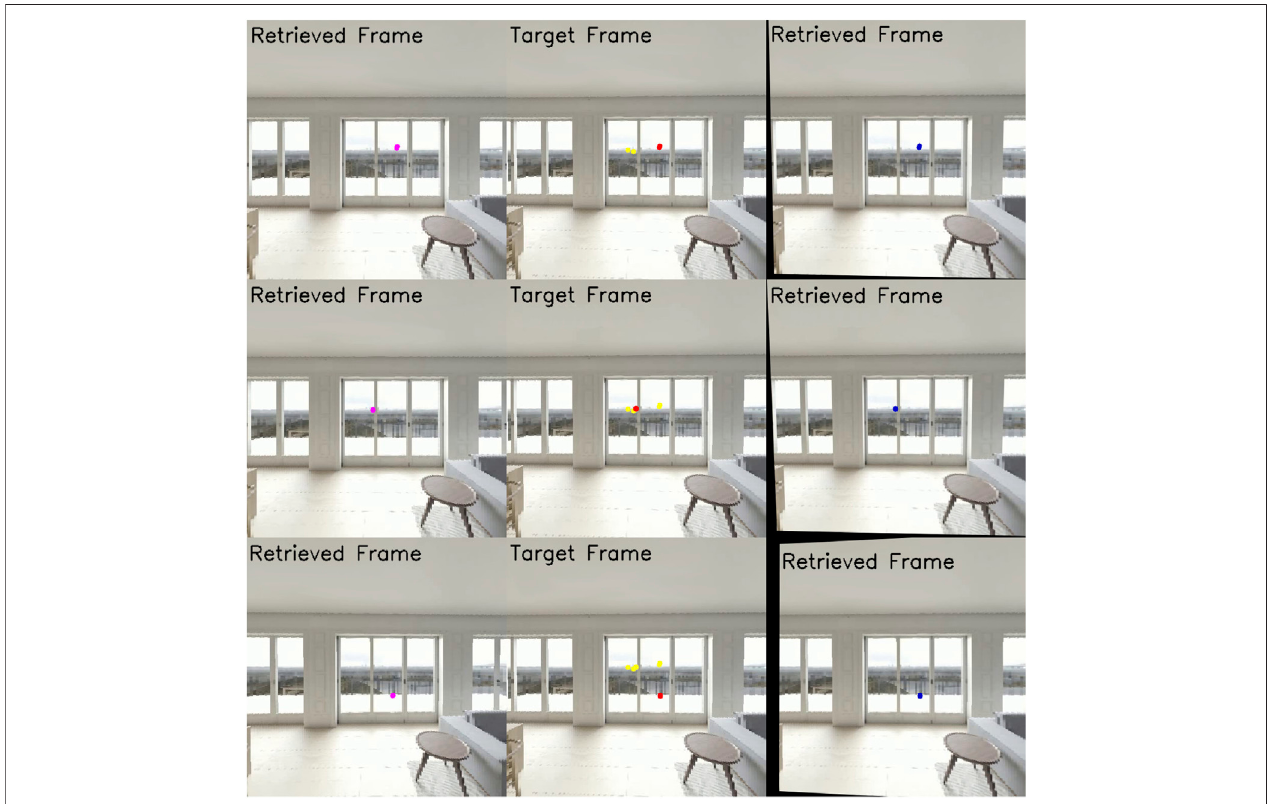
FIGURE3| Gazemappingfromtheretrievedframesontheleftontoasingletargetframeinthecenter.There-projectionoftheretrievedframetomatchthetargetis shown on theright. Theyellow dotsshow thegazedatathatisalready contained onthetargetframe,eitherbecausetheybelongtothetarget frameor throughprevious mapping steps. The magenta dots show the gaze retrieved with the retrieved frame. These blue dots correspond to their magenta counterparts, fi xating the same positioninsidetheimage. Thesemay, however, nothavethesame pixellocationastheoriginalmagentadots duetotheirprojection.Aftertheir projection, wehave shown the mapped gaze point as a red dot in the target frame, which is different from the retrieved frame. The shown re-projection is repeated multiple times to acquire the full fi xation map.